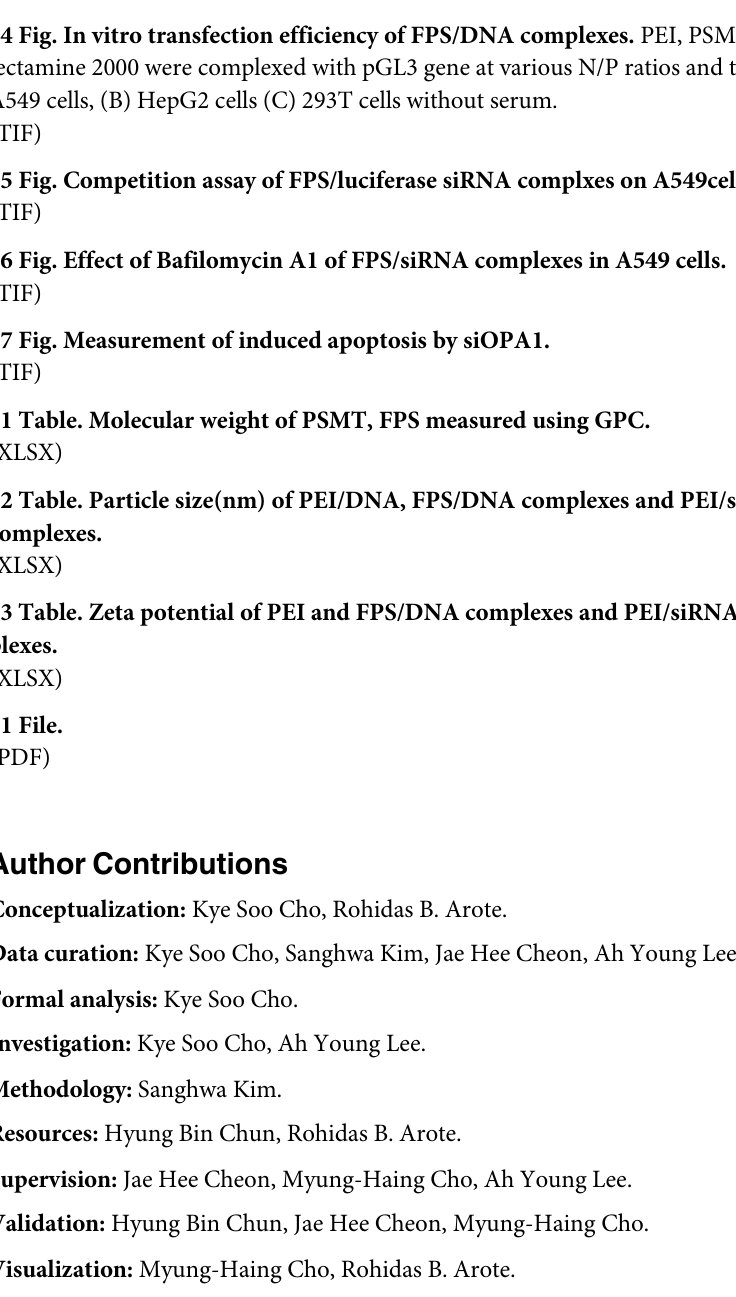
S3 Fig. Cytotoxicity of FPS/DNA and PEI/DNA complexes was measured by MTT assay